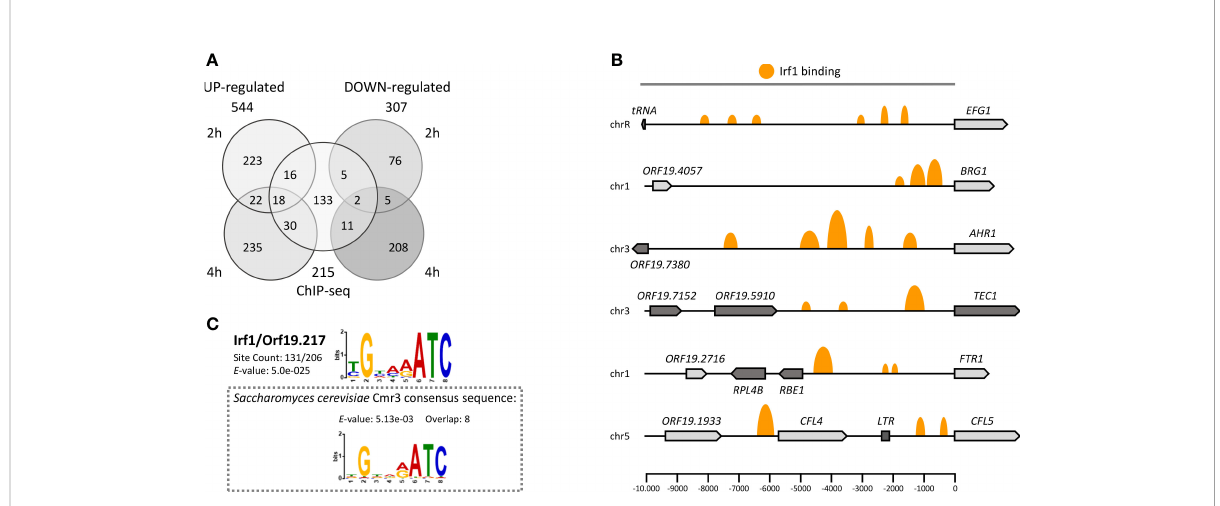
FIGURE 2 The Irf1 regulatory network in C . albicans . (A) Venn diagram showing the number of signi fi cantly up- and downregulated genes identi fi ed by RNA-Seq after 2 or 4 hours of overexpression of IRF1 from a tetracycline inducible promoter in YPD medium and the number of direct target genes identi fi ed by ChIP-Seq under the same conditions. (B) Schematic overview of Irf1 binding sites within selected promoter regions of identi fi ed target genes. The size of the orange marks re fl ects the log fold change between number of reads in the IP and control samples. (C) The binding motif of Irf1 was determined using the ChIP-MEME suite (https://meme-suite.org/). The identi fi ed motif is very similar to the binding motif of Cmr3 from S. cerevisiae